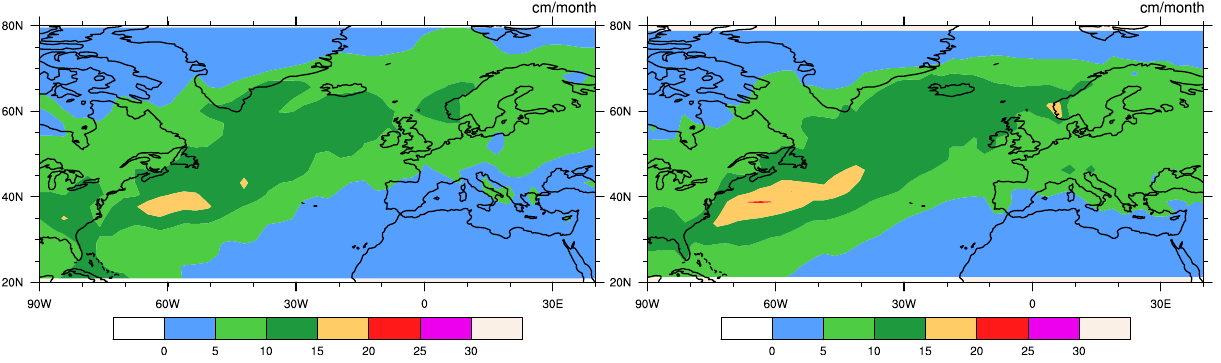
Fig. 1. Observed (Adler et al., 2003, Global Precipitation Climatology Project (GPCP)) (left) and modeled (right) average precipitation (in cmmonth − 1 ) between 1979–2004.